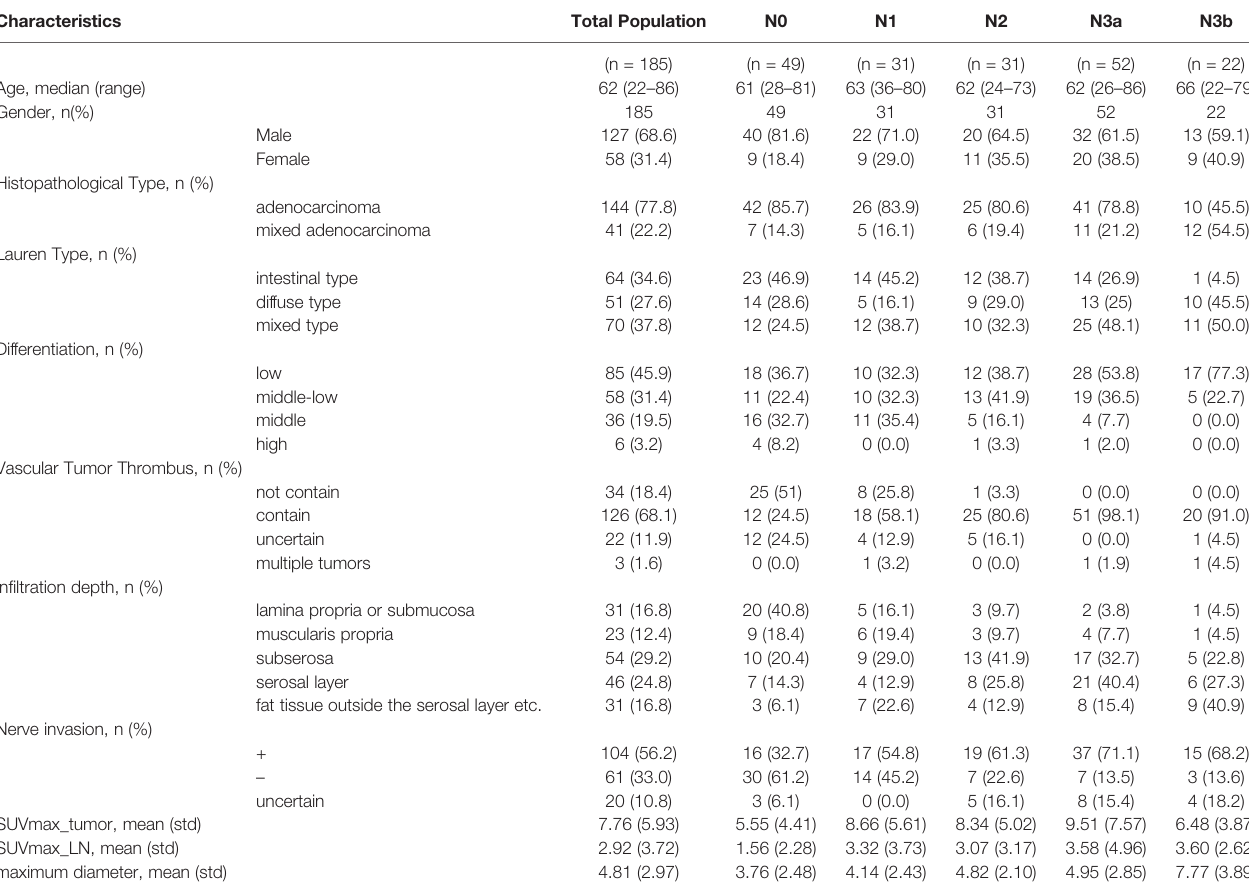
TABLE 1 | Demographic and clinical characteristics of the enrolled patients.